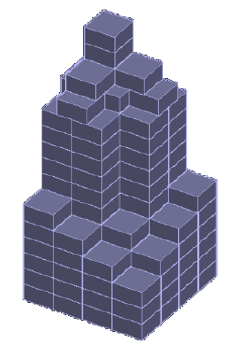
Figure 2: Reference model of the DUPLO TM brick